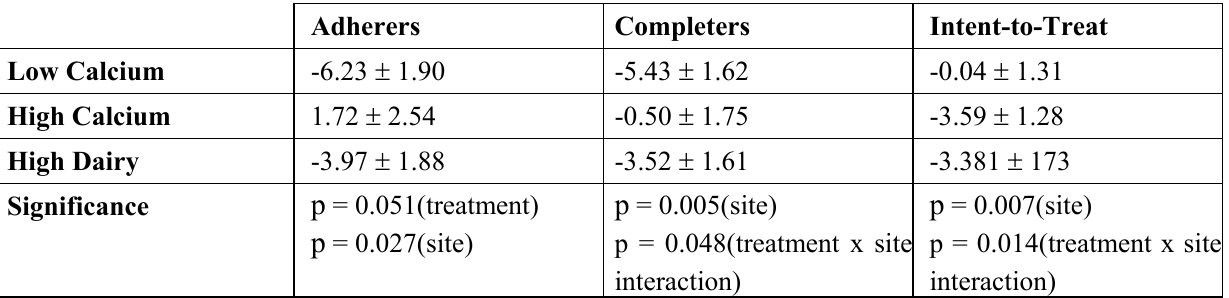
Table 4. Changes in Systolic Blood Pressure (mmHg) in Response to Dietary Treatments 1